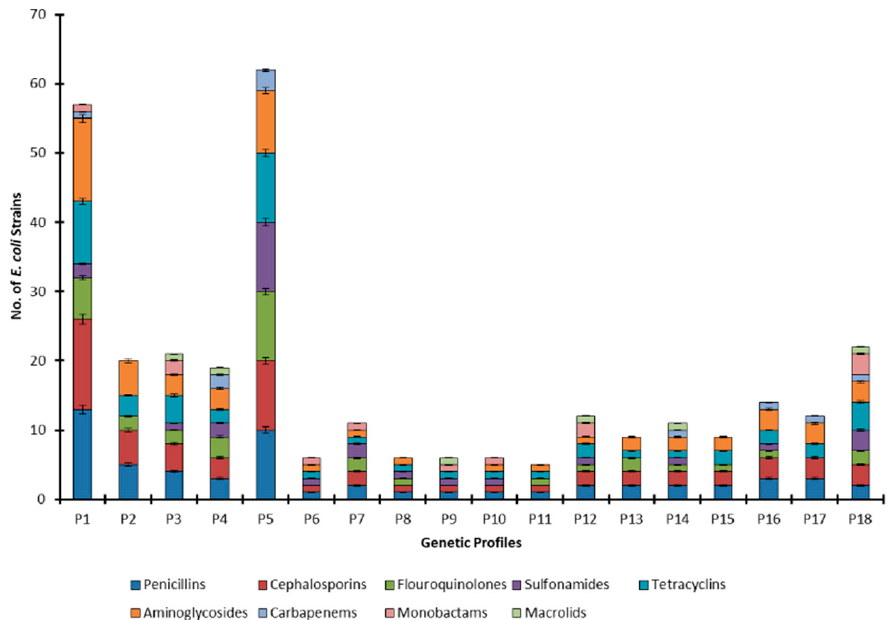
Figure 5. Antibiotic resistance pattern of E. coli strains based on genetic profiles.